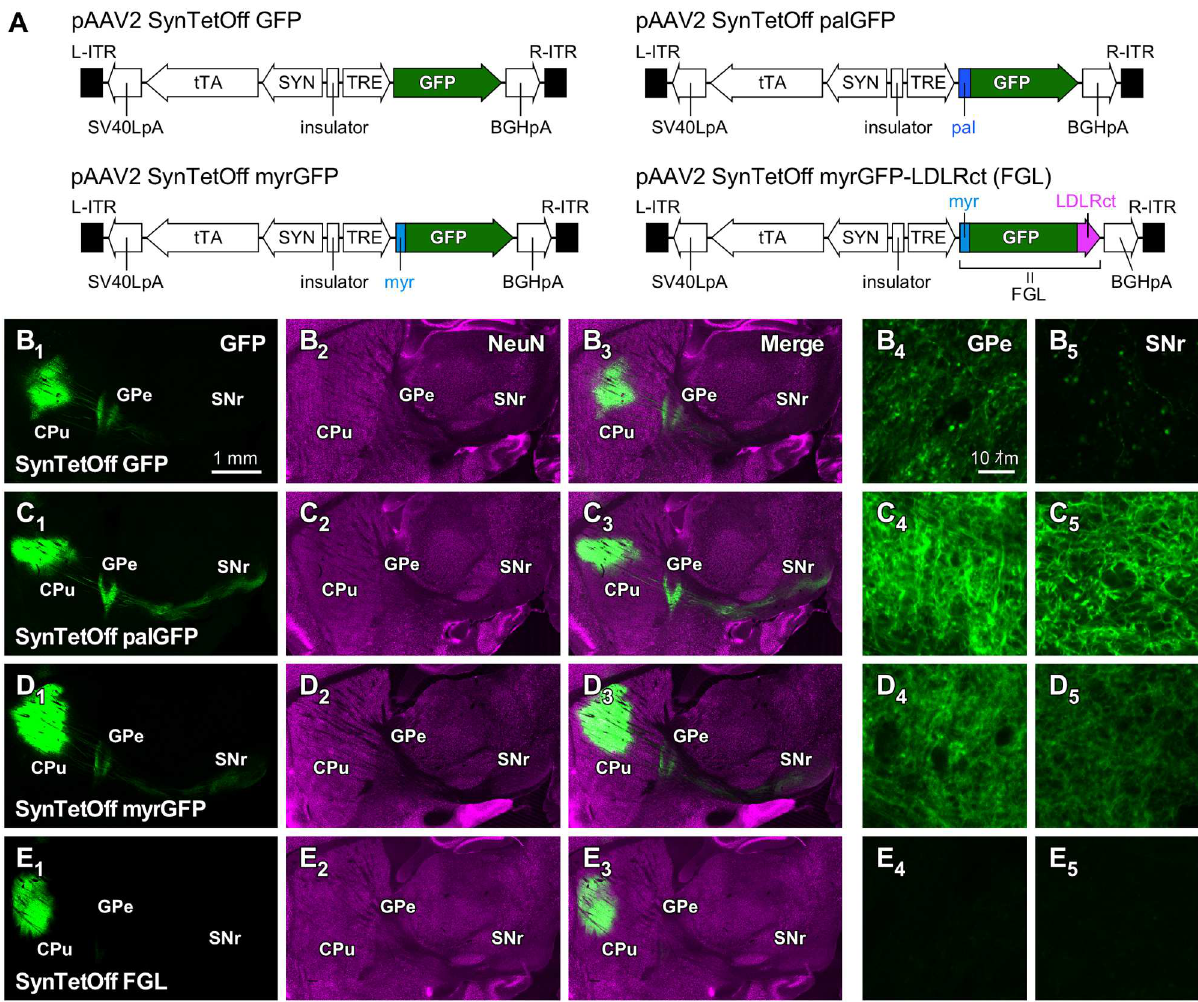
Fig 3. Axon labeling of neostriatal neurons with the AAV-SynTetOff vectors. ( A ) Construction of the vector plasmids, pAAV2-SynTetOff-GFP, pAAV2-SynTetOff-palGFP, pAAV2-SynTetOff-myrGFP, and pAAV2-SynTetOff-FGL. ( B–E ) Sagittal views of brain sections with injectionsof the AAV vectors. By additionof the palmitoylation site of the GAP-43 N-terminus (palGFP; C) or the myristoylation/ palmitoylation site of the Fyn N-terminus (myrGFP; D), axon fibers in the GPe and SNr were more clearly visualizedthan with GFP without membrane-targetingsignal (B). On the other hand, when a somatodendritic-targeting signal,LDLRct, was added to the C-terminus of myrGFP (FGL; E), axon fiber labelingin the GPe and SNr was mostly suppressed(E 4 , E 5 ). Scale bar in B 1 appliesto B 1 –E 1 , B 2 –E 2 ,